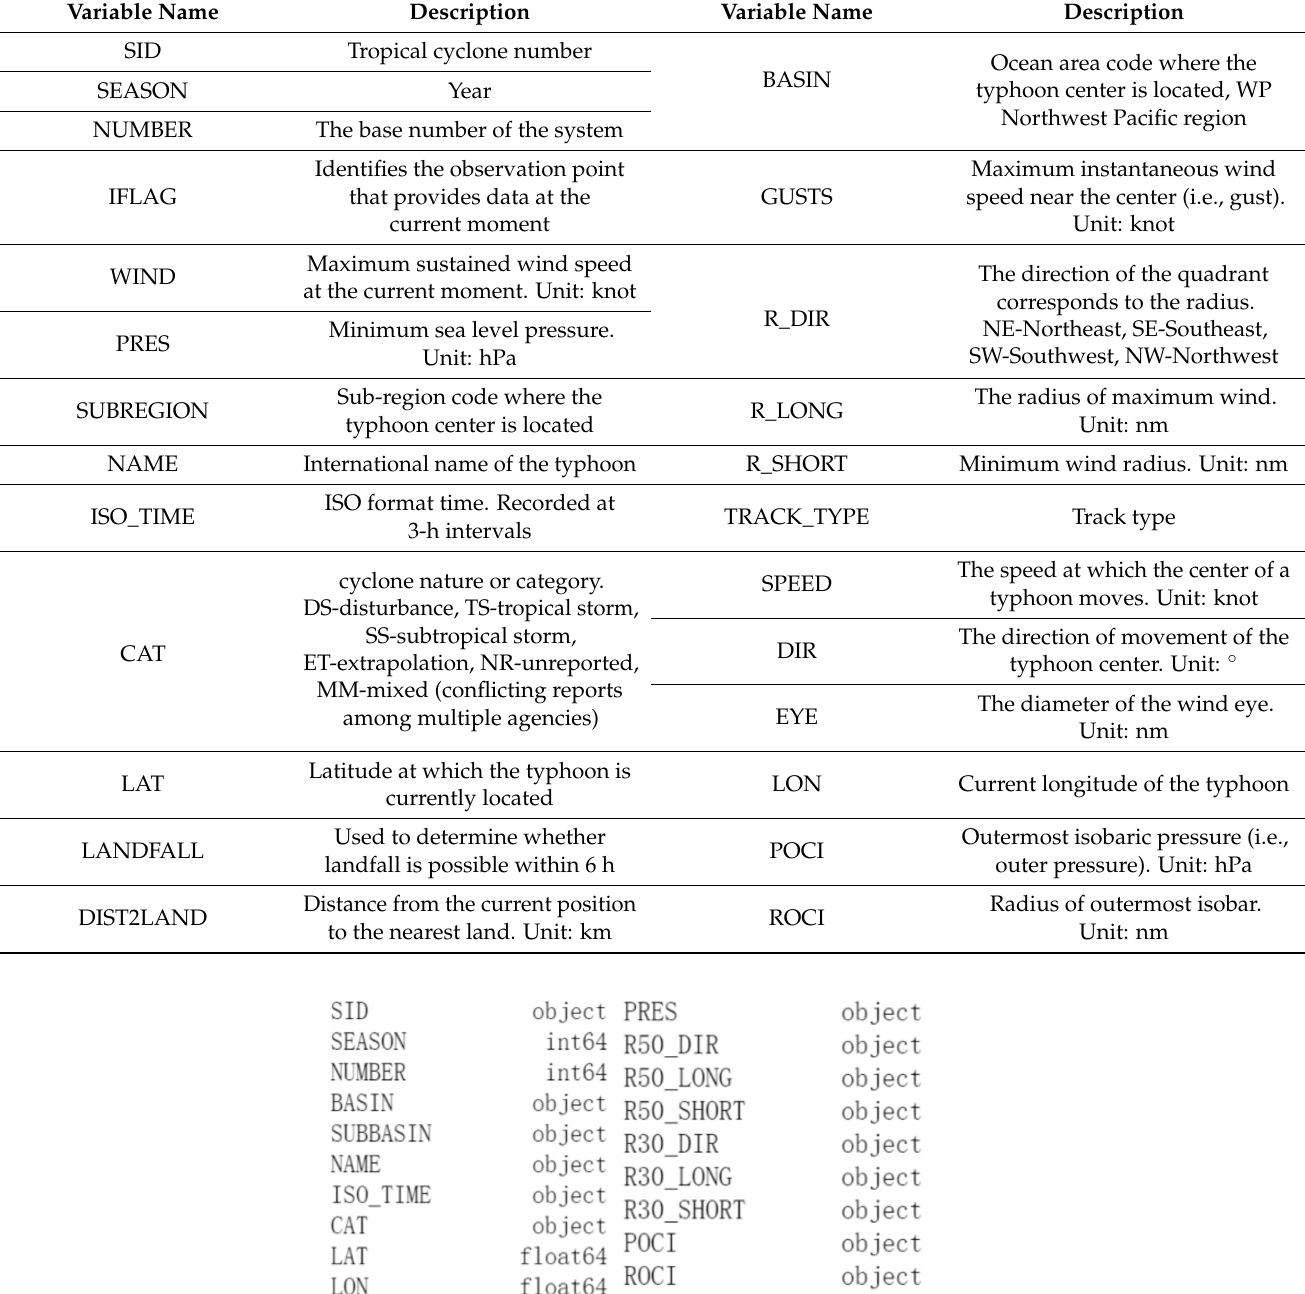
Table 1. The specific composition of the best path data set for South China Sea typhoons.